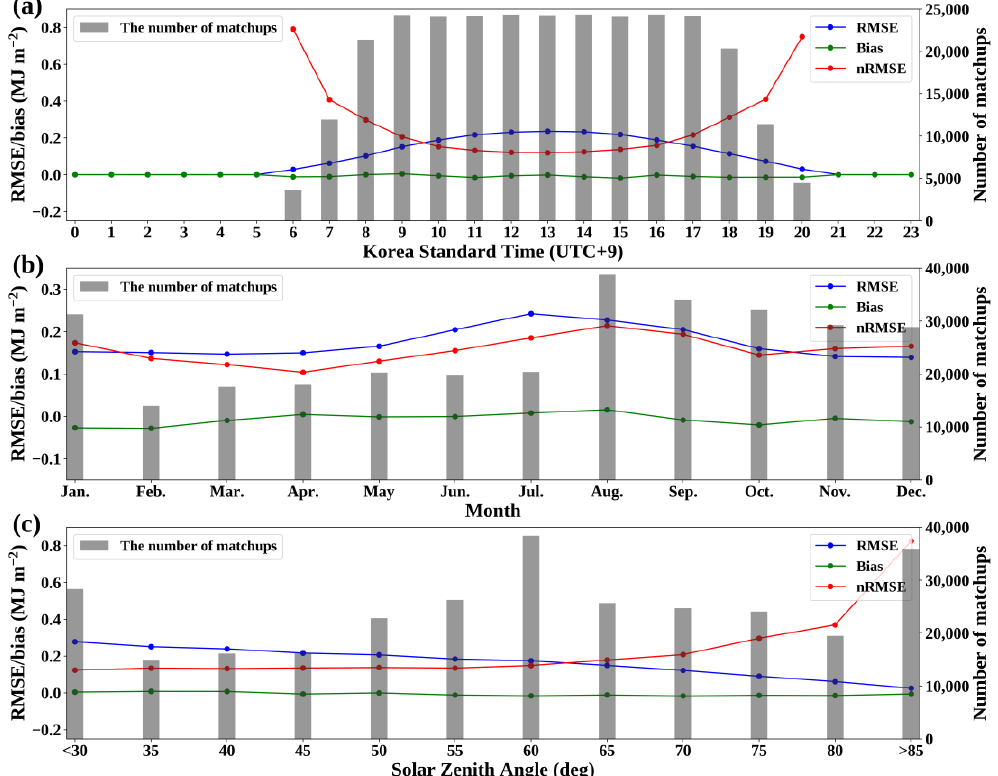
Figure 9. Variation of accuracy by comparison between GK2A/AMI-derived SSI estimates using the CNN model as the reference model and in situ SSI from ASOS stations operated by KMA with respect to ( a ) observation local time, ( b ) observation month, and ( c ) solar zenith angle; blue, green, and red lines represent RMSE, bias, and nRMSE, respectively, and the gray bars denote the number of matchups.